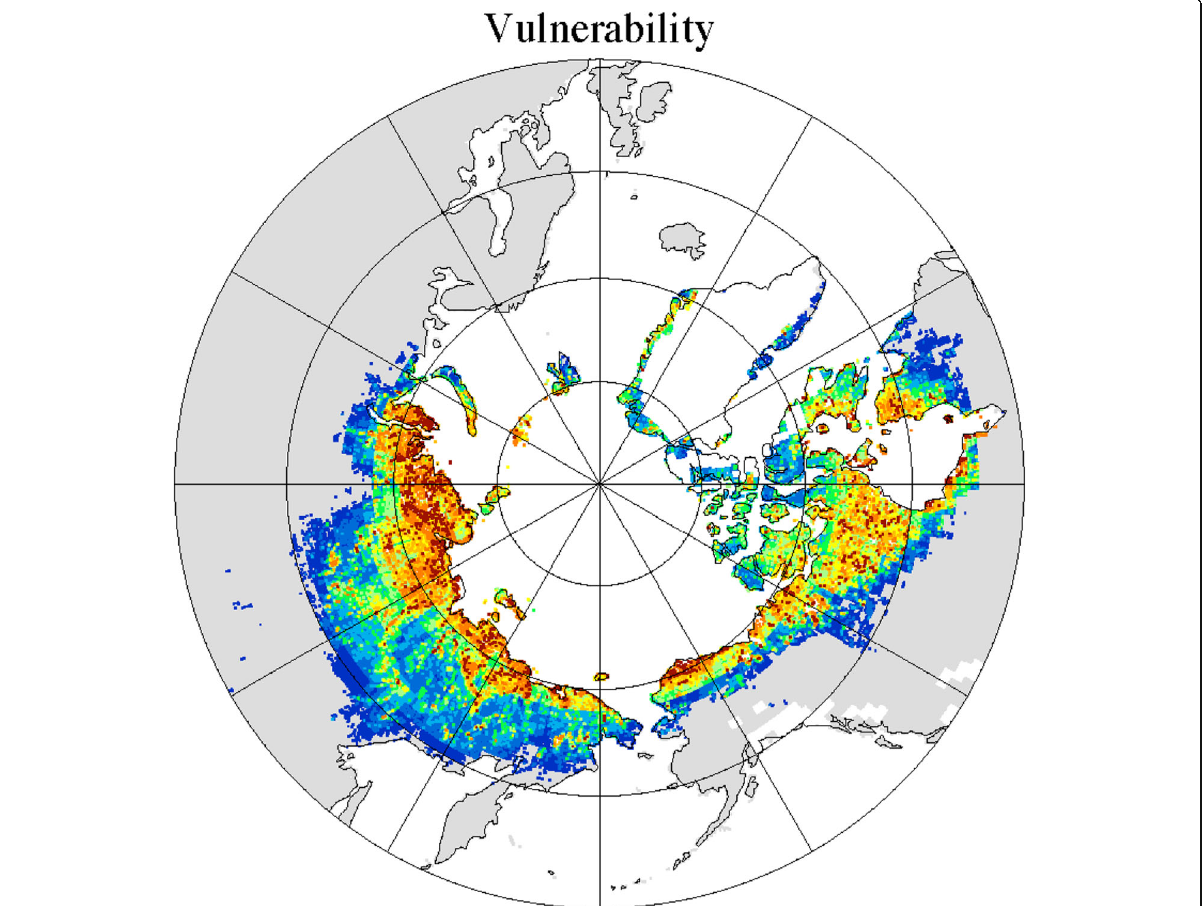
Fig. 7 High-resolution circum-Arctic map of vulnerability of ice-rich permafrost to degradation. The vulnerability is determined by the values of SOC and ground ice shown in Figs. 5e and